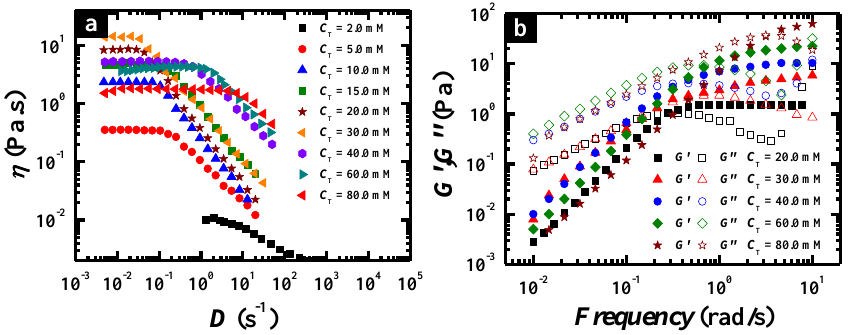
Figure 7. Rheological properties of C 12 C 3 C 12 (SO 3 ) 2 /CTAB mixtures at X g = 0.30 and pH 6.7. ( a ) Steady shear viscosity. ( b ) Elastic modulus G ′ and viscous modulus G ″ as functions of angular frequency ω .